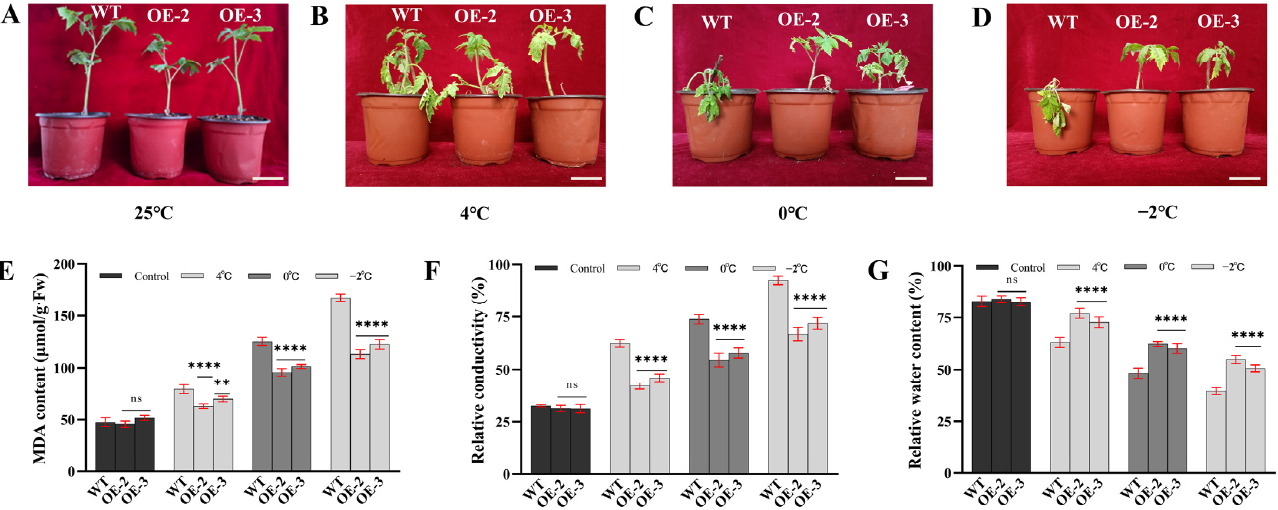
Figure 2. SiLEA5 gene endows transgenic tomato with low ‐ temperature tolerance. ( A ) Wild ‐ type and transgenic tomatoes were grown in a greenhouse at 25 ◦ C for 4 weeks of age. ( B ) Growth state of tomato plants treated with 4 ◦ C for 8 h, ( C ) 0 ◦ C for 6 h, ( D ) − 2 ◦ C for 4 h. ( E ) MDA content. ( F ) Relative conductivity content. ( G ) Relative water content. Data are means ± SD of three replicates. Ns indicate no significant difference between the wild-type and transgenic lines. Asterisk(s) indicate significant difference between the wild-type and transgenic plants by Student’s t -tests: ** p < 0.01, **** p < 0.0001. Bar = 4 cm.